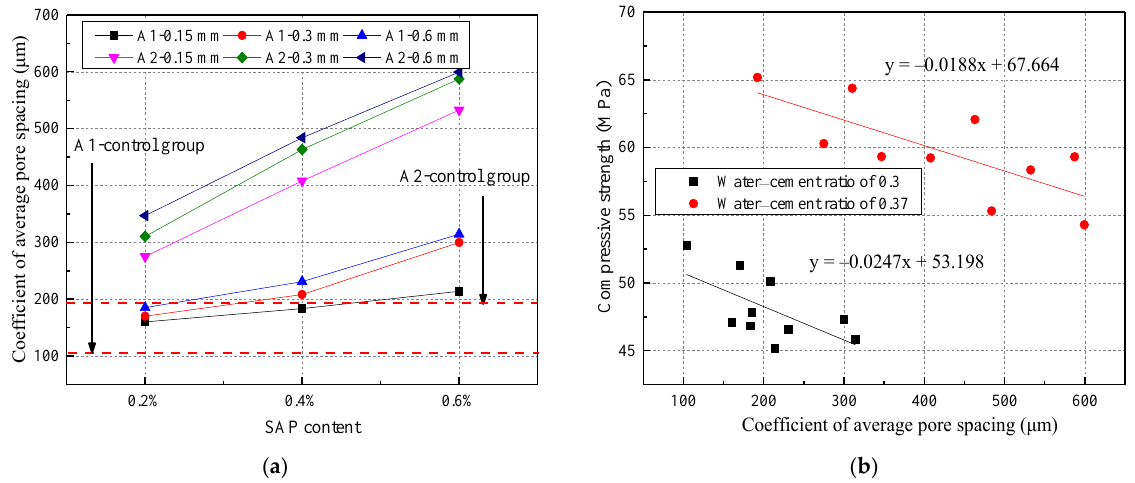
Figure 19. The effect of SAP on the coefficient of average pore spacing under different water–cement ratios: ( a ) different SAP content; ( b ) relationship between the coefficient of average pore spacing and compressive